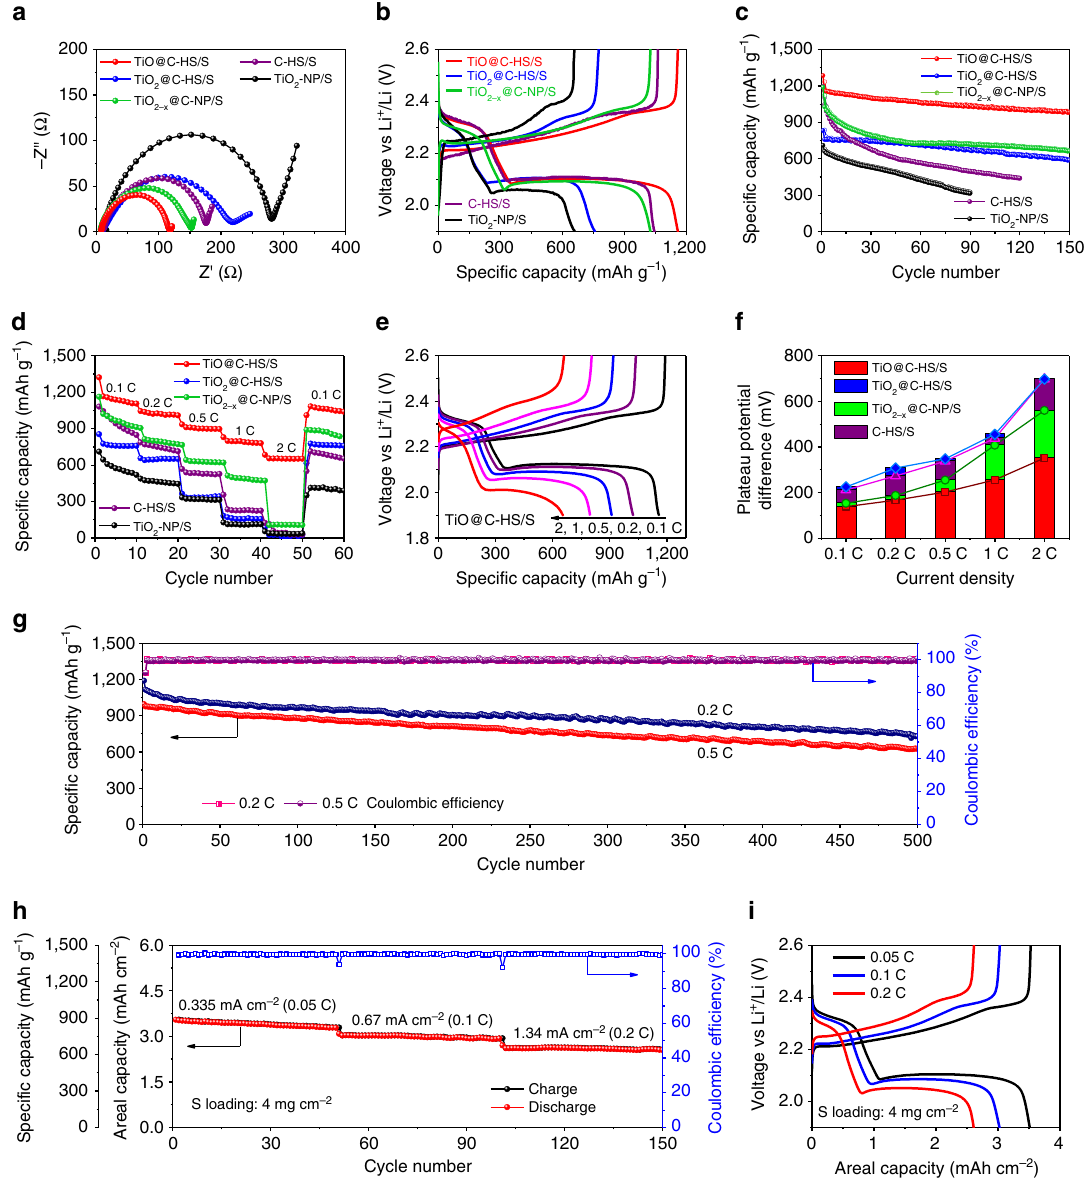
Figure 5 | Electrochemical evaluation of TiO@C-HS/S. ( a ) Nyquist plots before cycling from 1MHz to 100mHz, ( b ) the second-cycle galvanostatic charge/discharge voltage profiles at 0.1C, ( c ) cycle performances at 0.1C, ( d ) rate capabilities and ( f ) the potential differences between the charge and discharge plateaus at various current densities of the TiO@C-HS/S, TiO 2 @C-HS/S, TiO 2 (cid:2) x @C-NP/S, C-HS/S and TiO 2 -NP/S electrodes. ( e ) Voltage profiles at various current densities from 0.1 to 2C and ( g ) prolonged cycle life and Coulombic efficiency at 0.2 and 0.5C of the TiO@C-HS/S electrode. ( h ) Areal capacities and ( i ) voltage profiles at various current densities from 0.335 (0.05C) to 1.34mAcm (cid:2) 2 (0.2C) of the TiO@C-HS/S electrode with high sulfur mass loading of 4.0mgcm (cid:2) 2